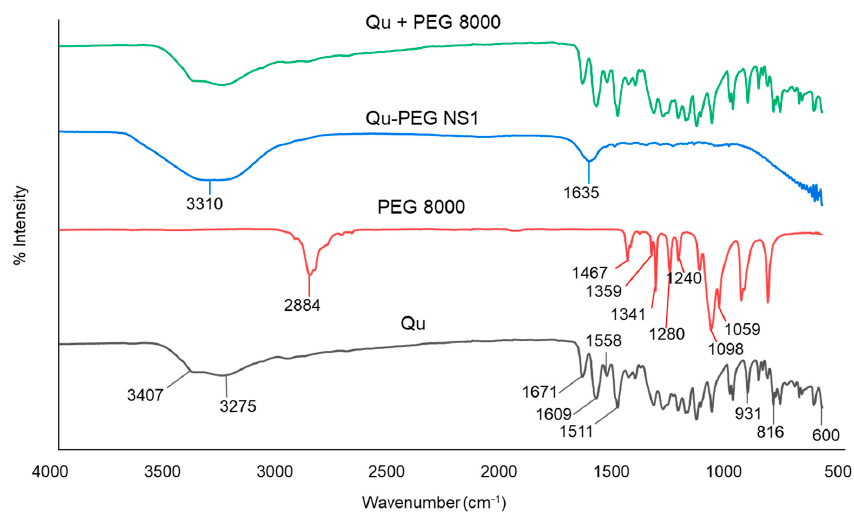
Figure 3. Attenuated total reflectance-Fourier transform infrared (ATR-FTIR) calculation of Qu, PEG 8000, Qu-PEG NS, and Qu + PEG 8000.